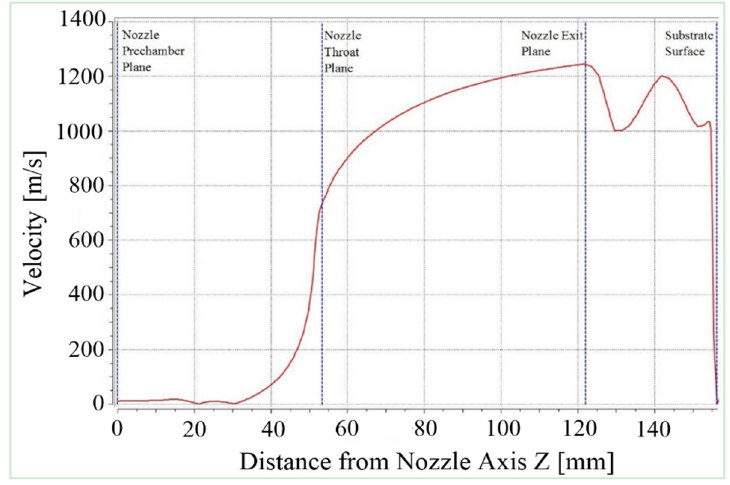
Figure 10. Computed velocity profile with respect to nozzle axis for cold spray supersonic jet at 800 °C and 3